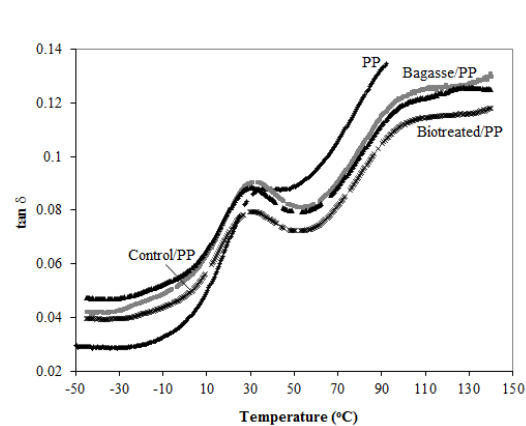
Fig 3. Storage modulus (E´) from PP composites reinforced with undecayed (control), decayed (biotreated) and in natura bagasses compared to neat PP.